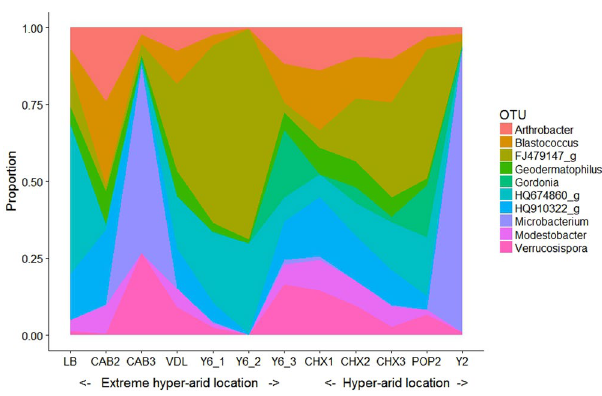
Figure 5. Relative abundance of actinobacterial genera detected in Atacama Desert locations. Relative abundance shown at 2.5% cut